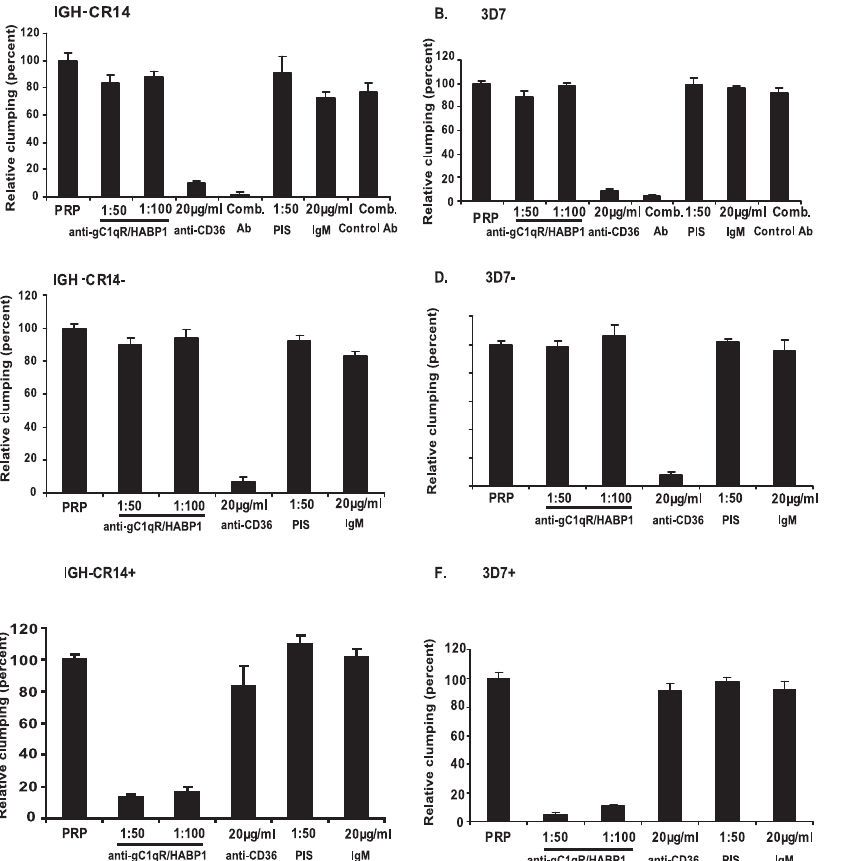
Figure 5. Inhibition of Platelet-Mediated Clumping of IRBCs by Mouse Serum Directed against gC1qR/HABP1 and Monoclonal Antibody against CD36 Parasite cultures in trophozoite and schizont stages were allowed to form clumps in the presence of PRP. Parasites were stained with acridine orange and the clumping frequency was determined by scoring the percentage of IRBCs found in clumps. Approximately 2,000 to 3,000 IRBCs were scored. The ability of anti-gC1qR/HABP1 mouse serum (anti-gC1qR/HABP1) or anti-CD36 mouse monoclonal IgM antibody (anti-CD36, clone SM U ) to inhibit clump formation was tested by pre-incubating platelets with antibodies prior to use in clumping assays. Pre-immune serum (PIS) from mice immunized with gC1qR/HABP1 and purified mouse IgM were used as controls. Clumping frequency in the presence of anti-gC1qR/HABP1 or anti-CD36 is expressed relative to clumping in the presence of PRP alone. Data represent average ( 6 standard error) of two independent experiments. Each assay was performed in duplicate. (A) IGH-CR14, (B) 3D7, (C) IGH-CR14 (cid:2) , (D) 3D7 (cid:2) , (E) IGH-CR14 þ , (F) 3D7 þ .